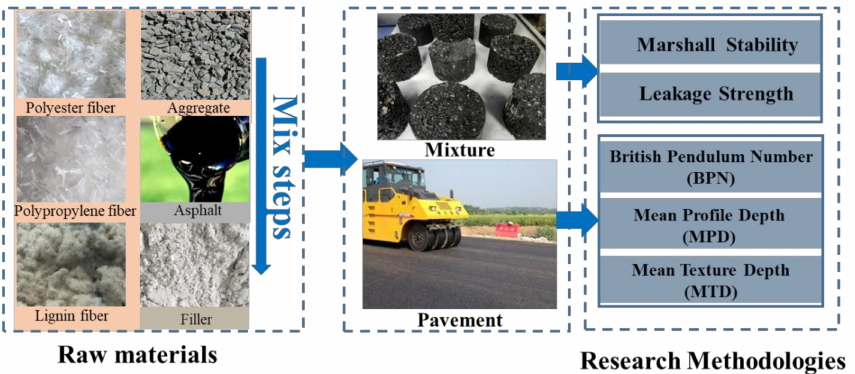
Figure 1. Research